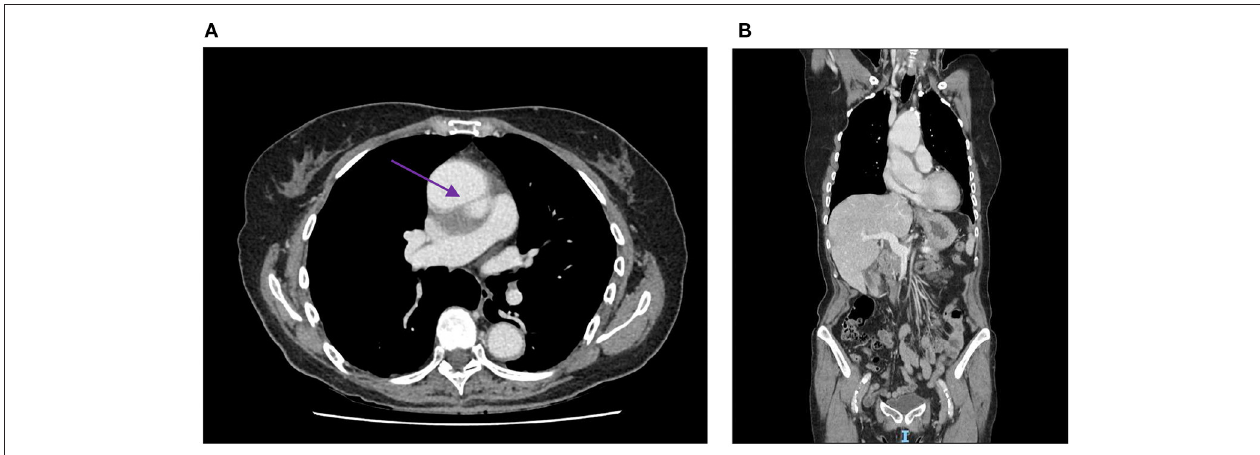
FIGURE 4 | (A) Contrast medium CT scan showing an aneurysm of the ascending aorta (53 × 54mm) with a tear of the intima, creating a thick false lumen (4mm), which is indicated by the purple arrow. (B) Sagittal section of the contrast medium CT scan, which also shows the aneurysm and thick tear of the intima. CT, computed